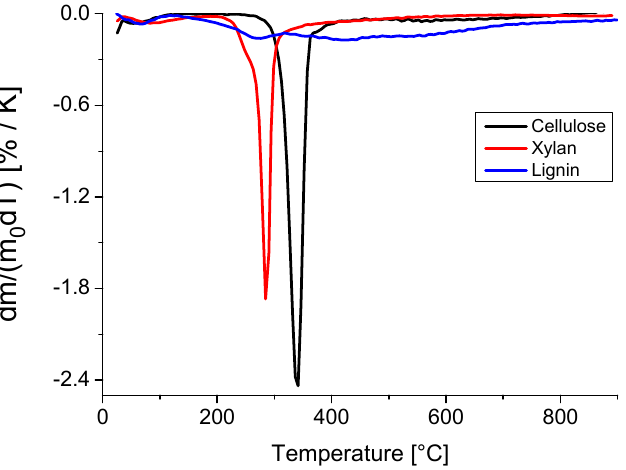
Figure 3. DTG curves of the model compounds cellulose, xylan and lignin, modified from [21].